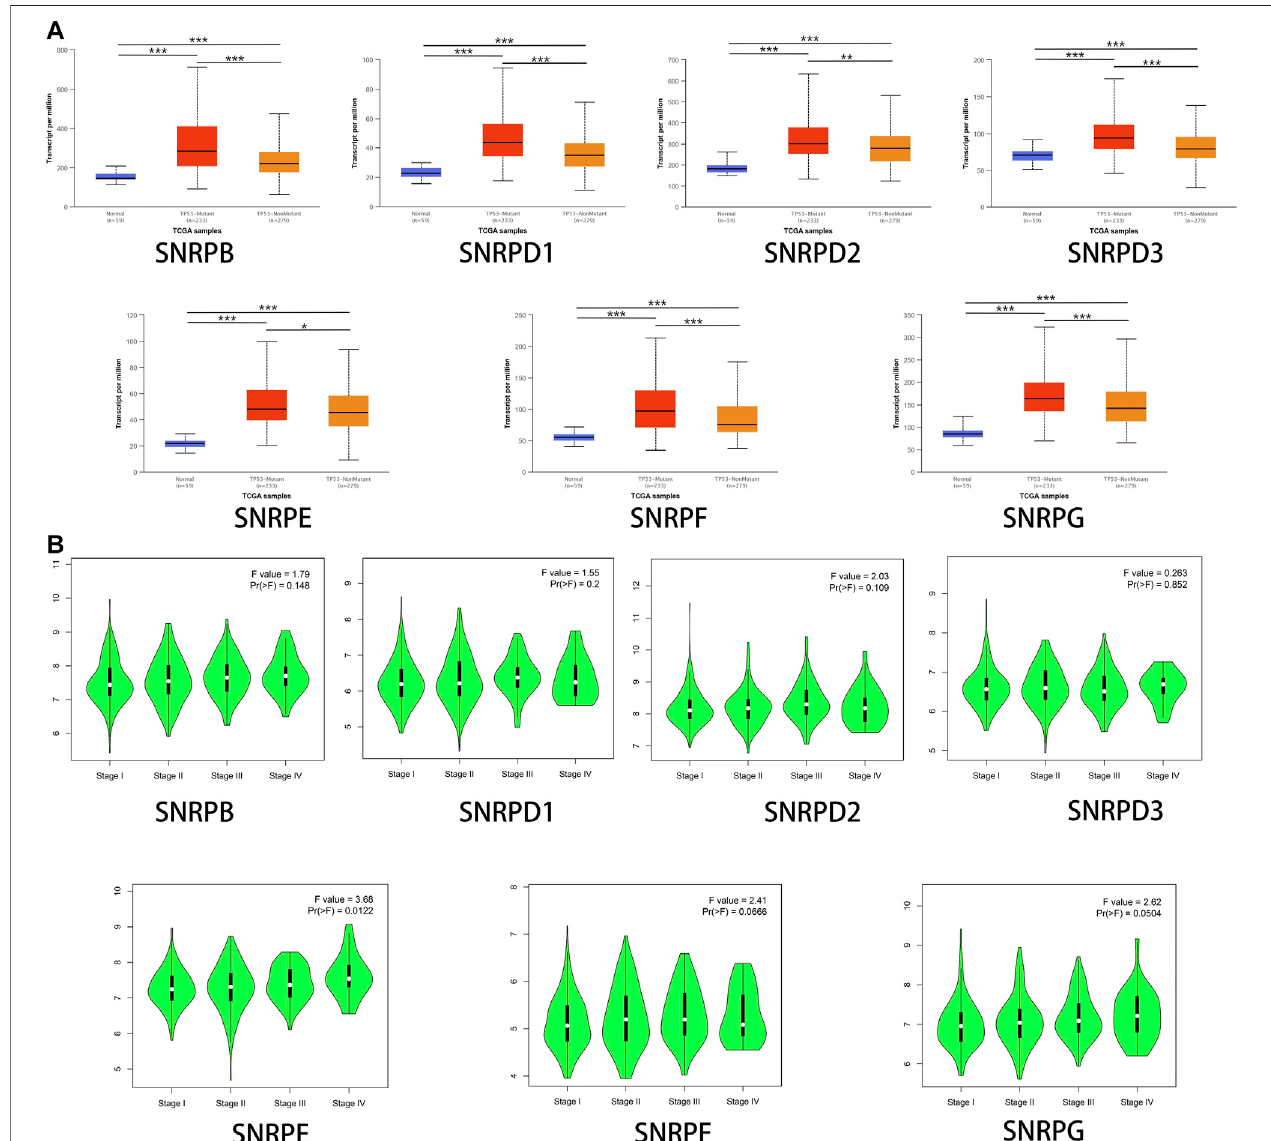
FIGURE 4 | The associations between genes for Sm proteins expression levels and clinicopathological parameters of LUAD patients. (A) Correlations between genesforSmproteinsexpressionlevelsandTP53mutationinLUAD(UALCAN). (B) AssociationbetweenmRNAexpressionofgenesforSmproteinsanddifferenttumor stages (GEPIA 2). ANOVA was performed to assess the statistical signi fi cance of the variations. F-value indicates the statistical value of the F test; Pr ( > F) indicates p value. A p value of < 0.05 was regarded as statistically signi fi